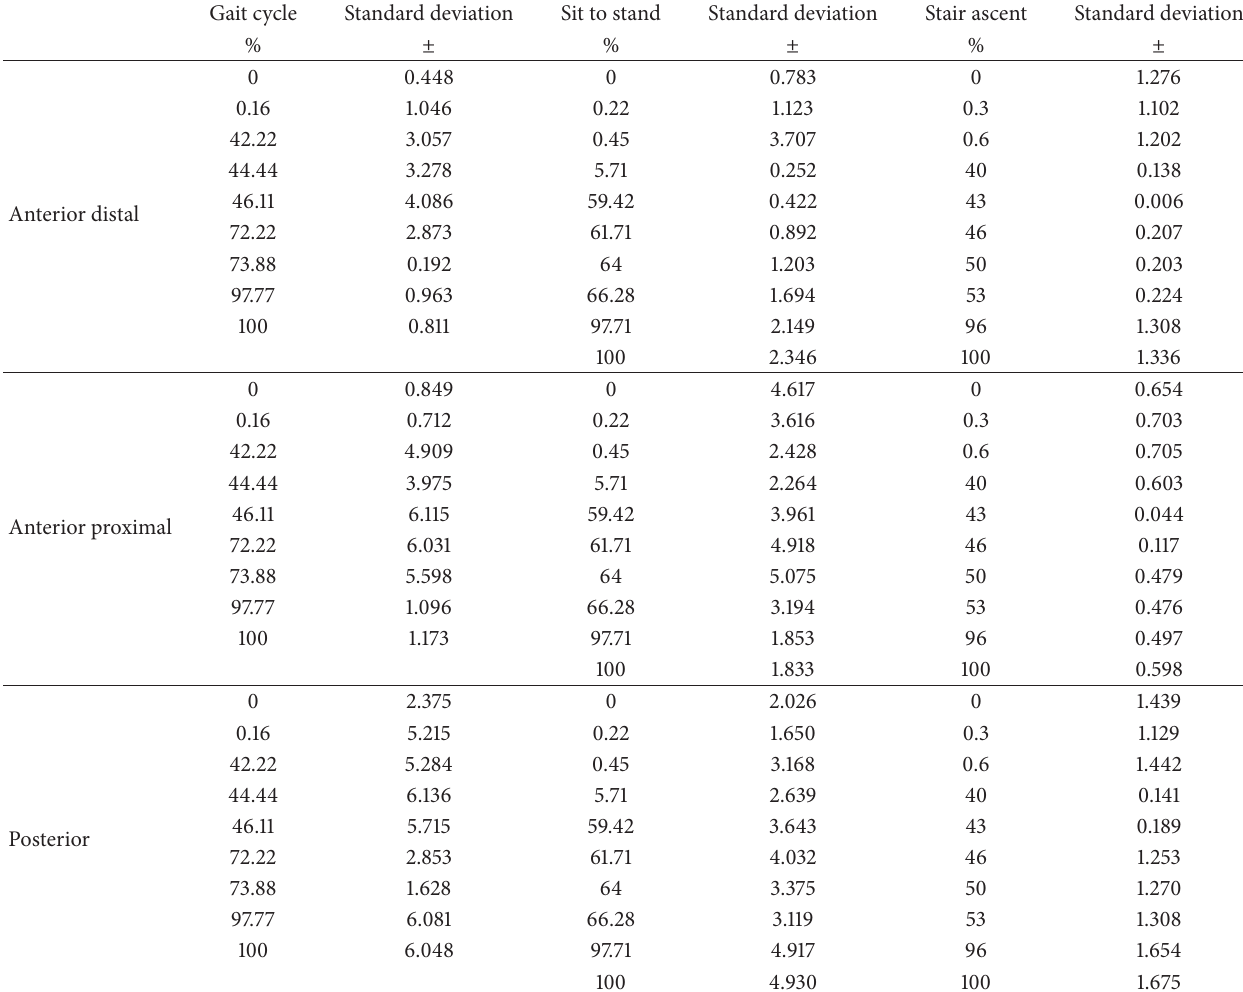
Table 3: Standard deviation values for